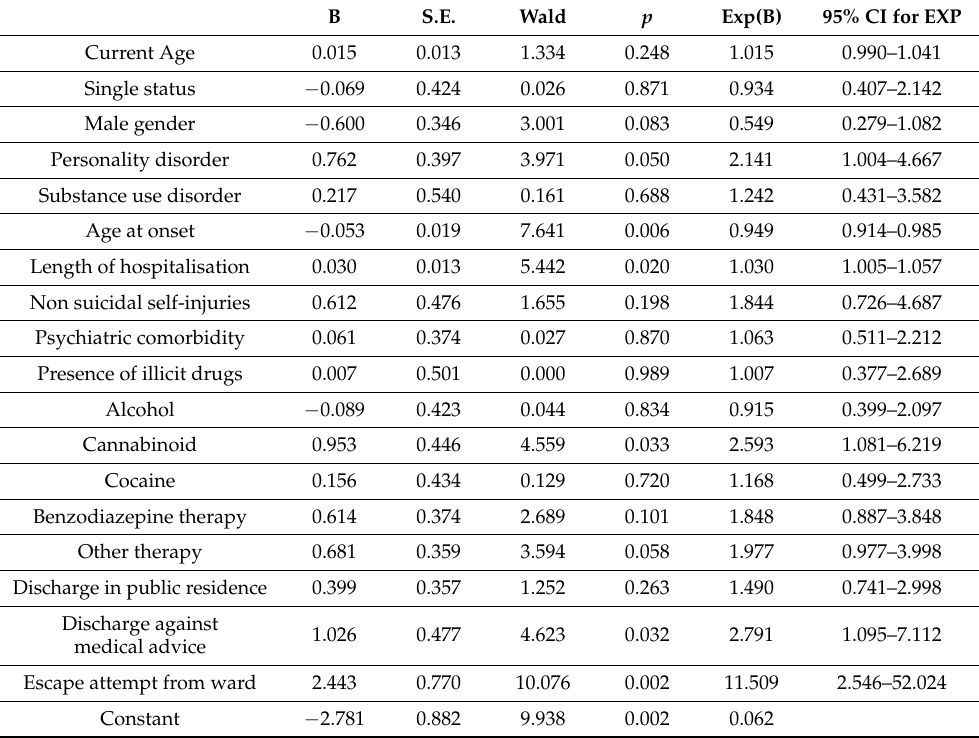
Table 5. Logistic regression analysis to explore the potential characteristics associated with the FSU